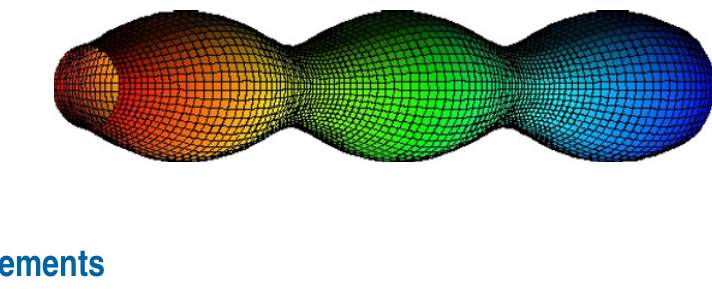
Figure 1. Unduloid surface in isothermic